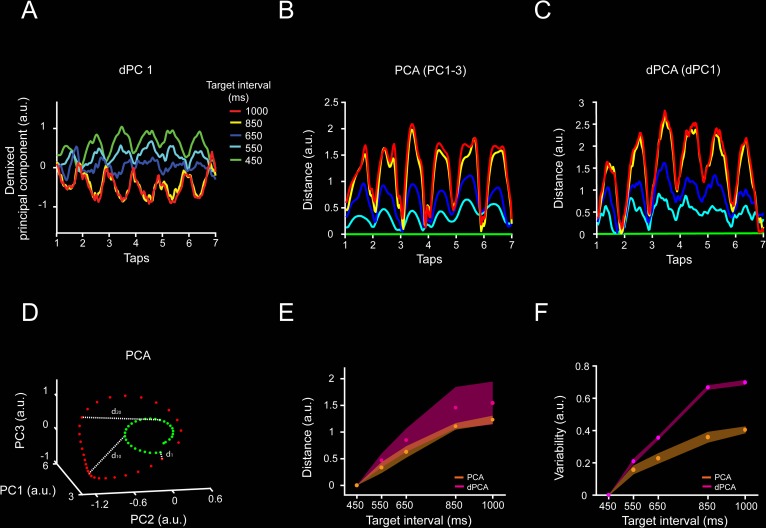
dPCA applied to neural population activity during SCT.A, dPC1 of the dPCA of the neural activity associated with the target interval (explains 7.8% of the total variance). Target interval in milliseconds is color coded (see inset A). The neural trajectories show oscillatory activity, and their amplitude varies across target intervals. B,C. Euclidean distance between the first PC of the 450-ms target interval and the first PC of each target interval across time for (B) time-normalized PCA and (C) dPCA. Target interval is color coded as in (A). Two-sample Kolmogorov–Smirnov test on the distributions of PCA and dPCA distances showed nonsignificant differences (p < 0.05) across target intervals. D. Distance calculation diagram for PCA data. The inter-tap trajectories for two target intervals are shown (green, 450 ms; red, 1,000 ms). The 450-ms target interval trajectory is used as the reference for distance calculation. The Euclidean distance between each sequential bin is calculated among the reference interval and the other target intervals trajectories. Both population analyses, PCA and dPCA, produced population signals with similar characteristics. Thus, oscillatory activity, modulation of the amplitude with the target interval, and an intersection close to the tap time are characteristics of the underlying neural population activity, irrespective of the dimension reduction algorithm. E. Mean inter-tap Euclidean distance (mean ± SD) between the 450-ms and each target interval for the PCA data using PC1–3, (orange) and dPCA using dPC1 (magenta). There was no significant difference between the slopes of PCA and dPCA (slope t test = 1.97, p = 0.0539) F. Variability of the distance between the 450-ms and each target interval for the PCA (orange) and dPCA (magenta). The variability increased monotonically as a function of the target interval for both analyses. Underlying data are available in https://doid.gin.g-node.org/d315b3db0cee15869b3d9ed164f88cfa/. a.u., arbitrary unit; dPCA, demixed PCA; PC, principal component; PCA, principal component analysis; SCT, synchronization-continuation task.